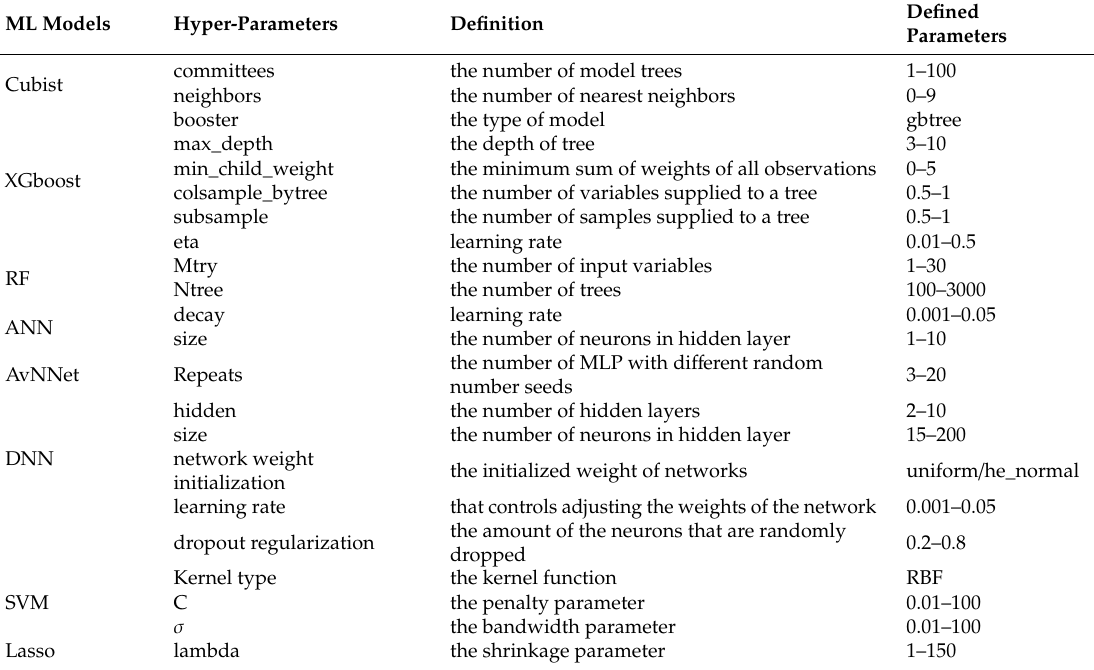
Table 3. Hyper-parameters of ML models tuned in this